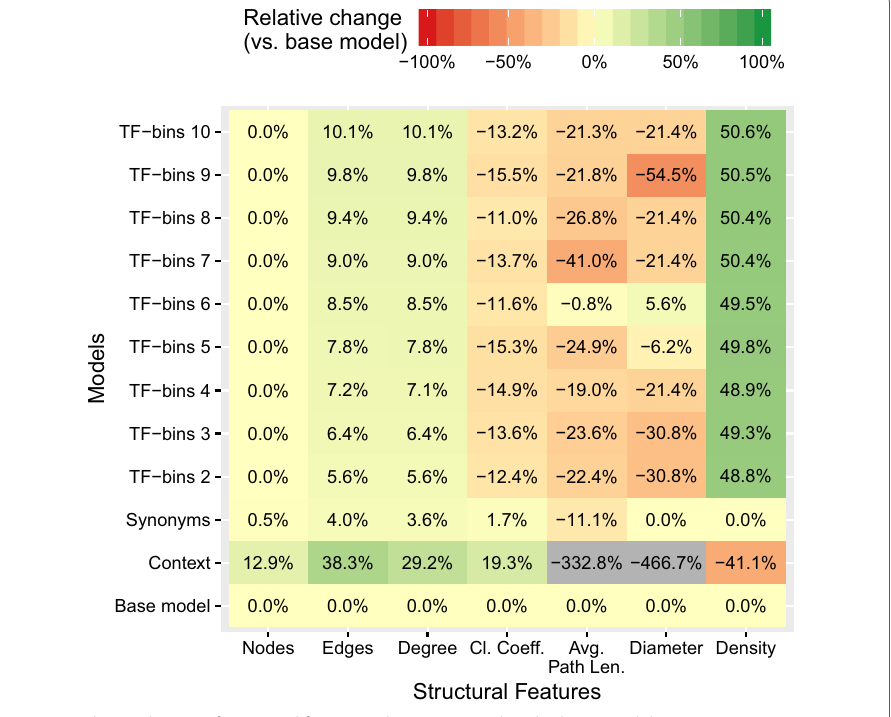
Fig. 30 Relative change of structural features when compared to the base